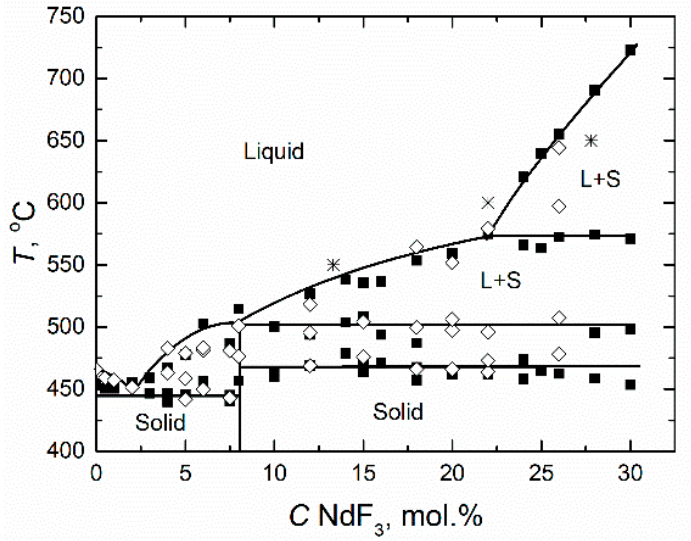
Figure 8. Phase diagram of the FLiNaK-NdF 3 system: ■ —TA by cooling curves; ◊ —DSC; *—data [14].